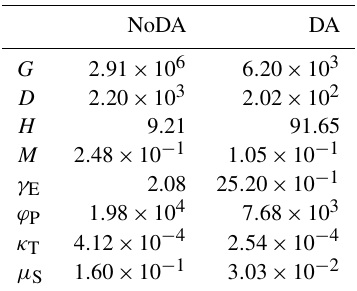
Table 4. RMSE of the no data assimilation (NoDA) experiment and the data assimilation (DA) experiment in which all observations are assimilated every 10 years, with 5000 ensembles, in experiment 3 (see Sect.